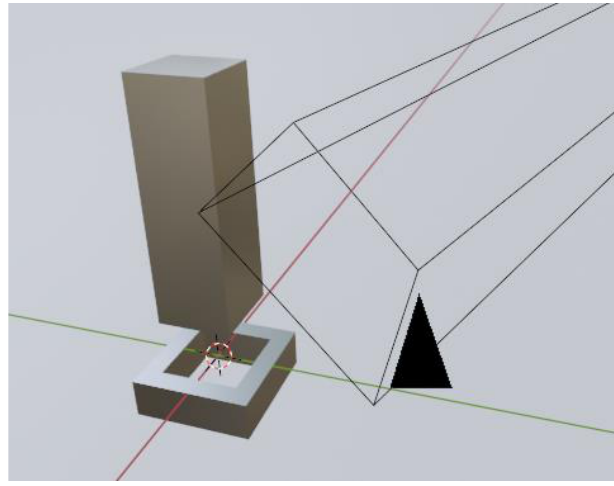
Figure 6. The virtual scene for peg-in-hole assembly.